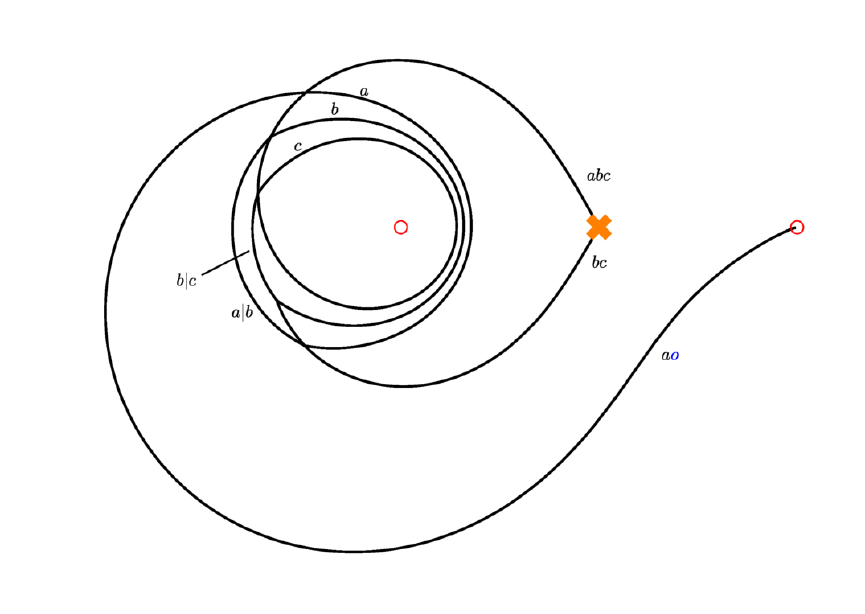
Figure 57. D4 + 3D0, two (++) = ( (cid:0)(cid:0) ) streets corresponding to the partitions (3) and (1,1,1).